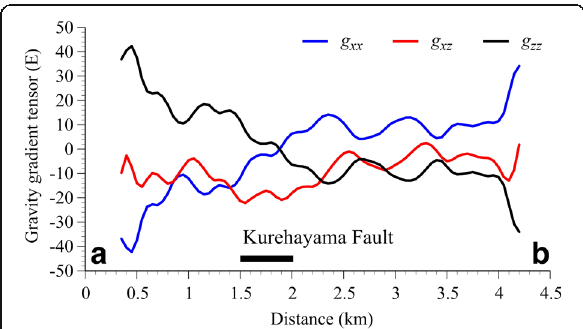
Fig. 9 Gravity gradient tensor ( g xx , g xz (= g zx ), g zz ) on the profile. These are estimated from the Bouguer anomalies on the profile shown in Fig. 8. The component of g xx and g xz is calculated by a finite-difference method of gravity vectors g x and g z in the space domain. The “ Kurehayama Fault ” shown in this figure indicates a rough fault location by Toyama City (Toyama City 2013). The unit of the gravity gradient tensor is given in E (Eötvös), and 1 E =0.1 mGal/km